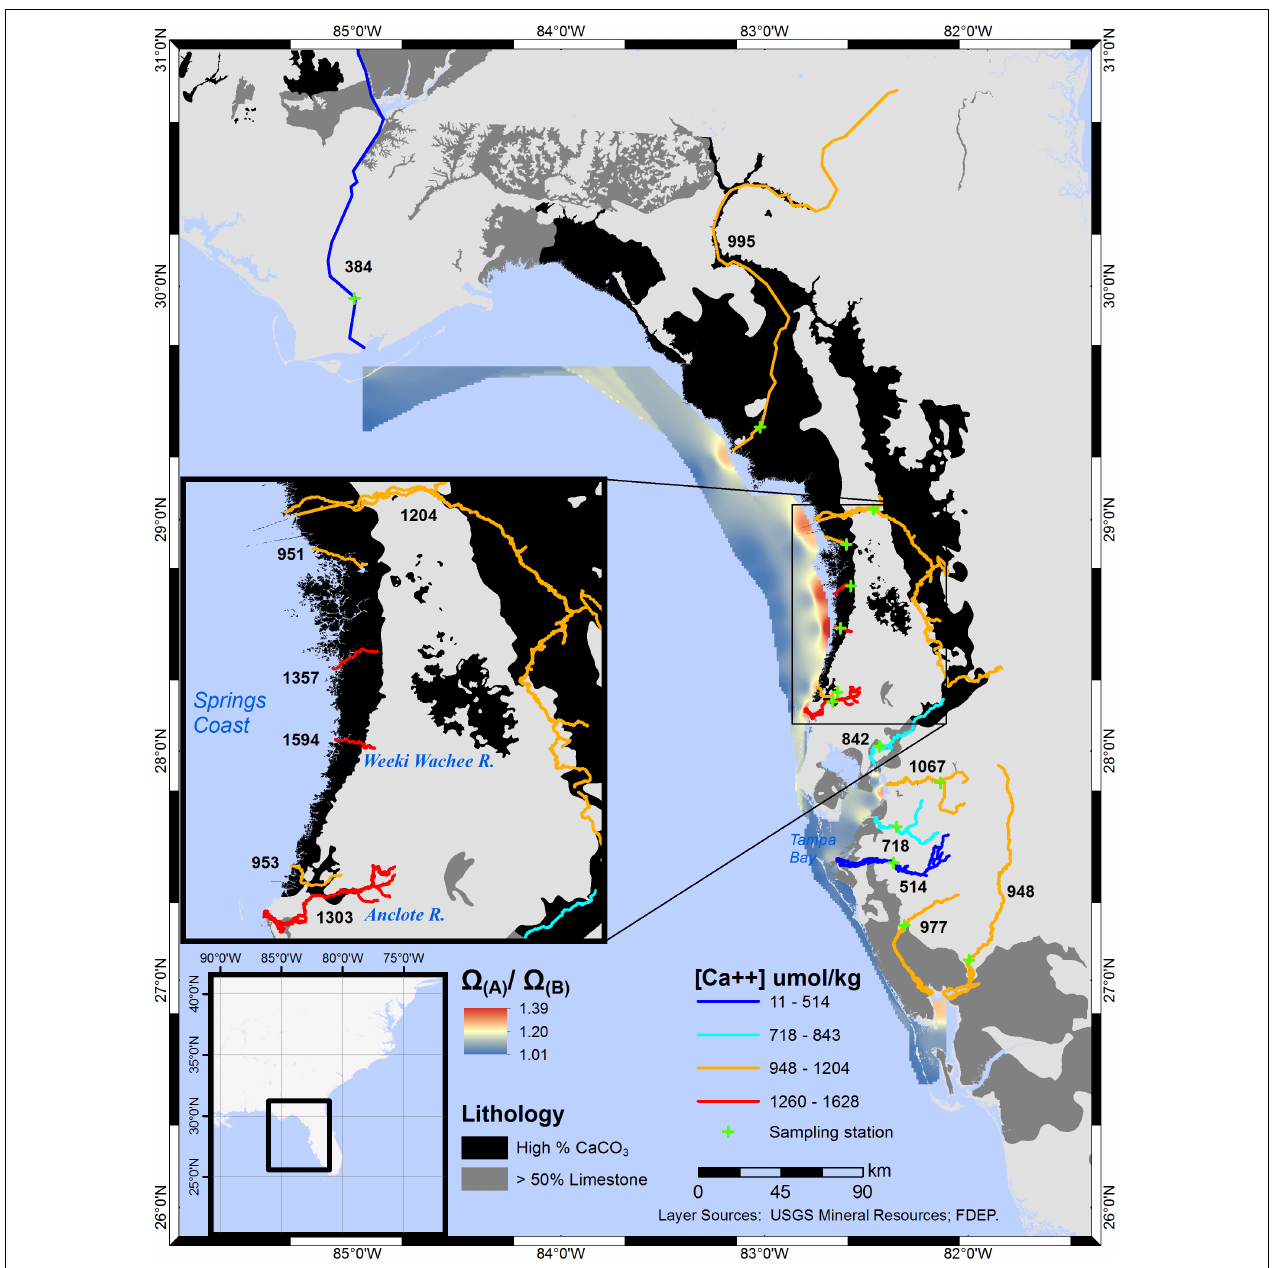
FIGURE 3 | Interpolated (cid:127) ( A ) / (cid:127) ( B ) ratios for central-west and central-north Florida coastal waters. Averaged calcium ion concentrations for individual sampling stations, in µ mol/kg, are labeled adjacent to each river. Comparing the Manatee and Weeki Wachee Rivers ([Ca 2 + ] = 514 and 1594 µ mol/kg, respectively), the (cid:127) -ratio, assessed at S = 20, translates to a 4 and 12% increase, respectively, in calculated (cid:127) values. The boundaries of the interpolation approximately encompass the mesohaline and polyhaline regions (S ∼= 5–30) in Oct–Dec (5 years mean), as estimated from NOAA satellite